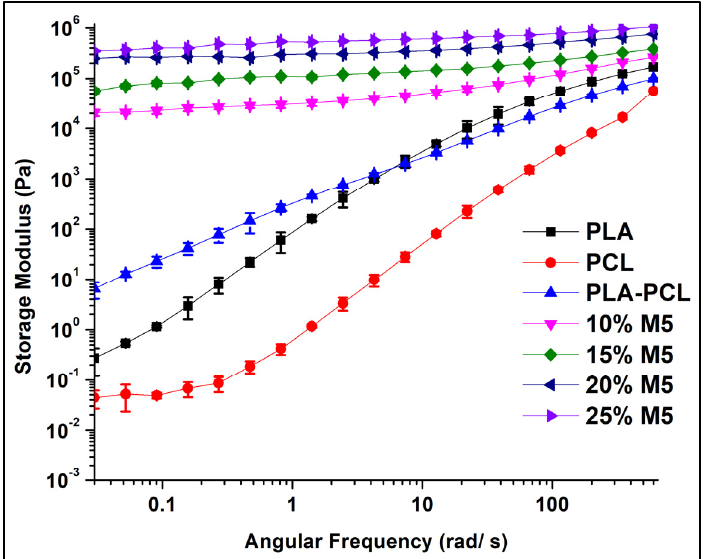
Figure 11. The storage modulus curves of PLA, PCL, and PLA/PCLs blends and their composites.